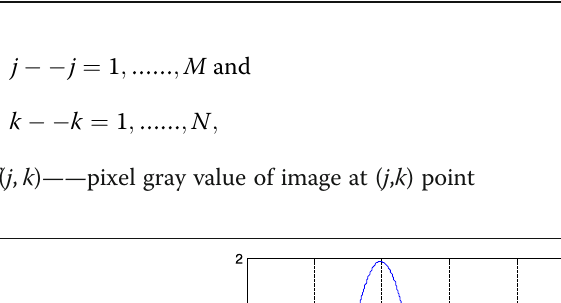
Fig. 10 Simulink simulation of the composite axis control